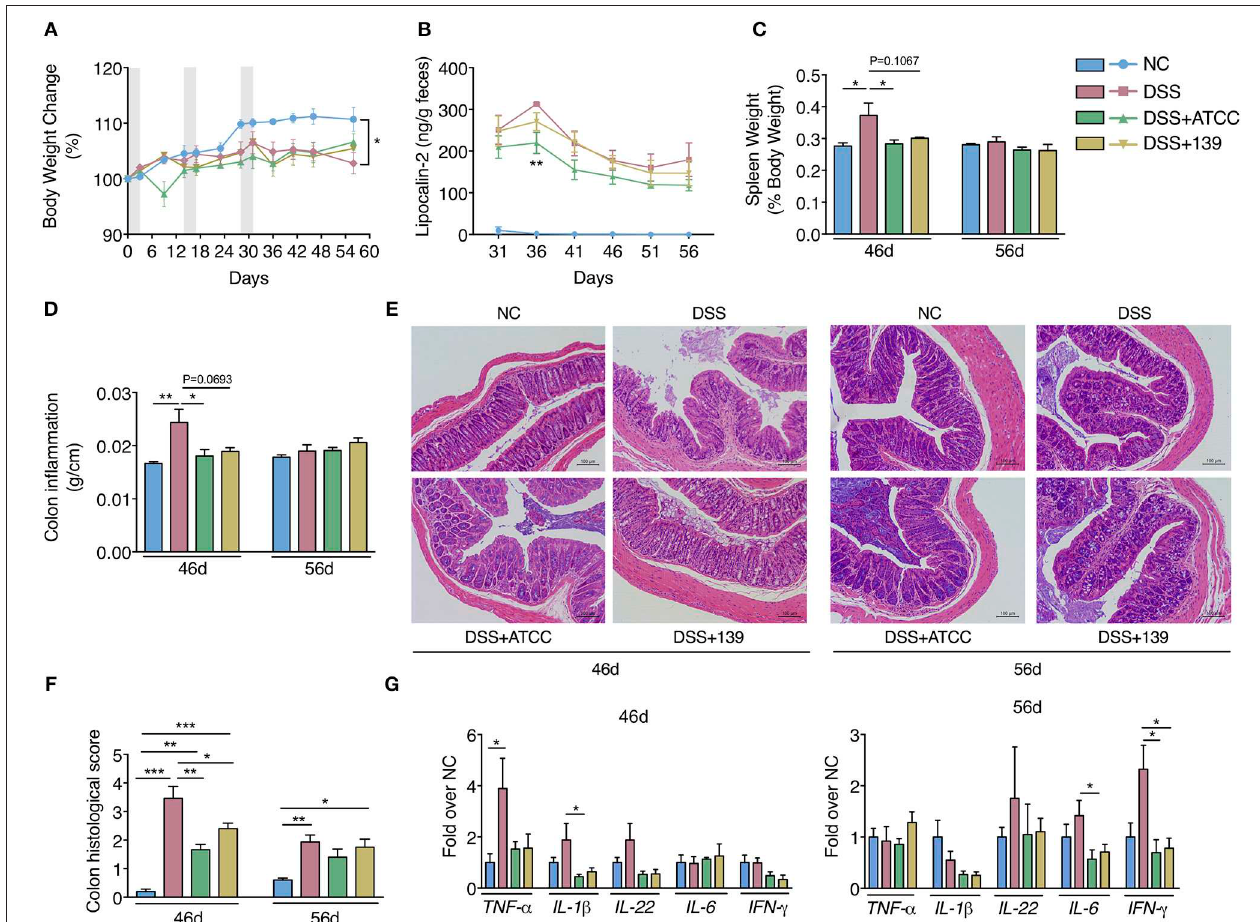
FIGURE 3 | A. muciniphila strain ATCC and 139 showed strain-specific anti-inflammatory effects on the chronic colitis of mice. (A) Body weight change of mice (normalized to the original weight). Periods of DSS treatment were shadowed. (B) Fecal lipocalin-2 contents. (C) Spleen weight (ratio to body weight). (D) Conlon inflammation index (colon weight/length). (E) Representative hematoxylin-eosin stained sections of distal colon at day 46 and 56 (200 × ). (F) Histological scores of colon sections. (G) Colon mRNA expression of several pro-inflammatory mediators relative to β -actin in mice. For body weight and fecal lipocalin-2 level, n = 10 per group before 46d time point, n = 5 per group from 46d time point. For other data, n = 5 per group for each time point. Data are shown as means ± s.e.m. Values of each group were calculated by one-way analysis of variance (ANOVA) followed by Tukey’s post-hoc test. For graph (A,C–G) * P < 0.05, ** P < 0.01, *** P < 0.001. For graph (B) , ** P < 0.01 compared with DSS